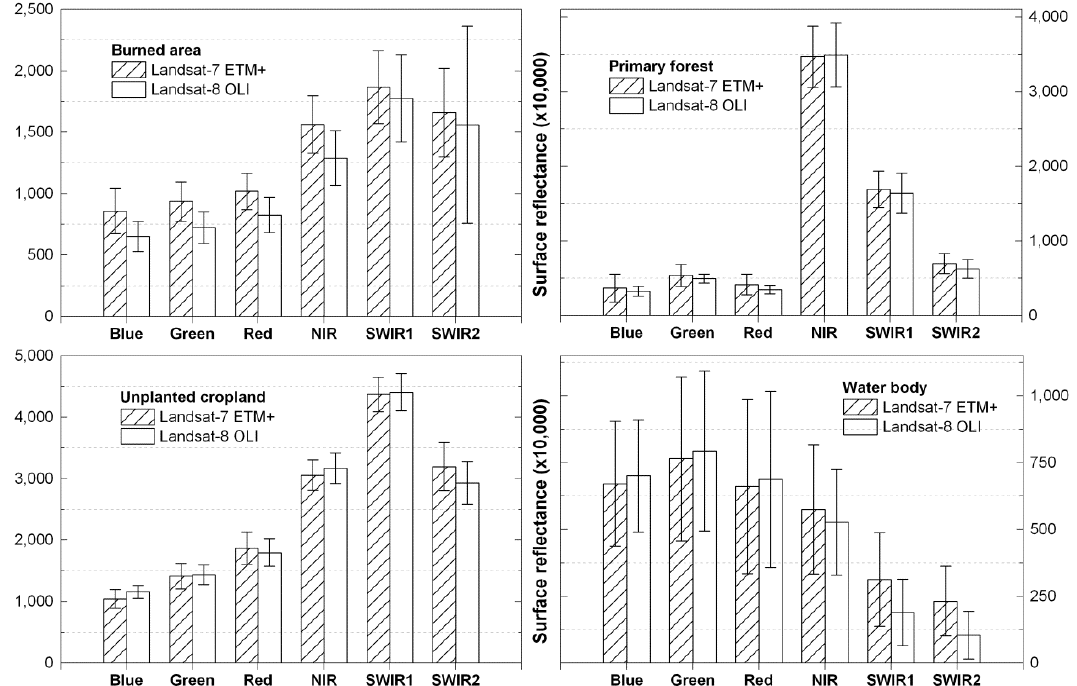
Figure 6. Band differences of Landsat-7 ETM+ and Landsat-8 OLI images (3 April 2013 and 1 April 2013) for four land-cover types (primary forest, unplanted cropland, swidden field and water